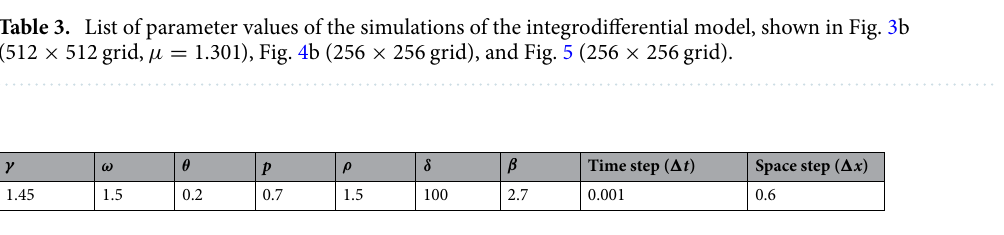
Table 4. List of parameter values of the simulation of the reaction–diffusion model, shown in Fig. 3c ( 512 × 512